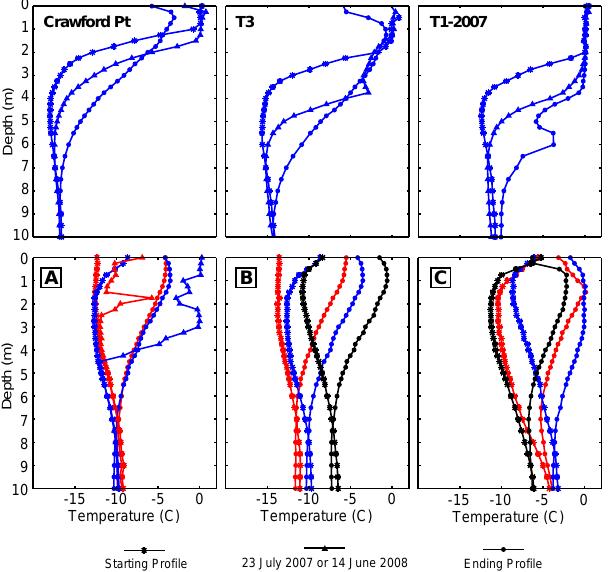
Figure 5. Select temperature profiles at various sites showing the evolution of the temperature profile over the melt season. Start- ing and ending profiles correspond to the starting and ending dates used for the refreezing calculation at each site (see Table 1). Pro- files with triangles correspond to 23 July 2007 at 2007 sites and 14 June 2008 at 2008 sites. On these dates, significant refreezing events occurred at most sites along the transect. (a) T1-2008 pro- files. (b) T2-08 (red), T1-08 (blue), H163 (black). (c) H2 (red), H3 (blue), H4